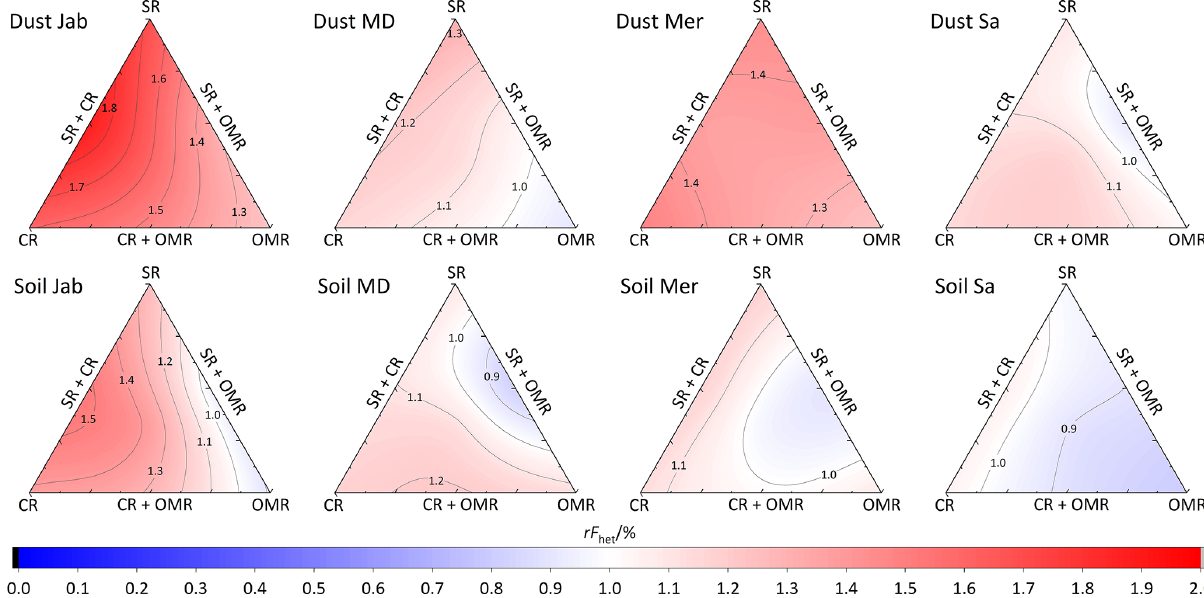
Figure 5. Effects of treatments in terms of rF het(treatment / natural) for soil and dust samples at 5wt% concentration. SR: salt removed; CR: carbonate removed; OMR: organic matter removed; SR + CR: salt and carbonate removed; SR + OMR: salt and organic matter removed; SR + CR + OMR: salt-, carbonate-, and organics-removed